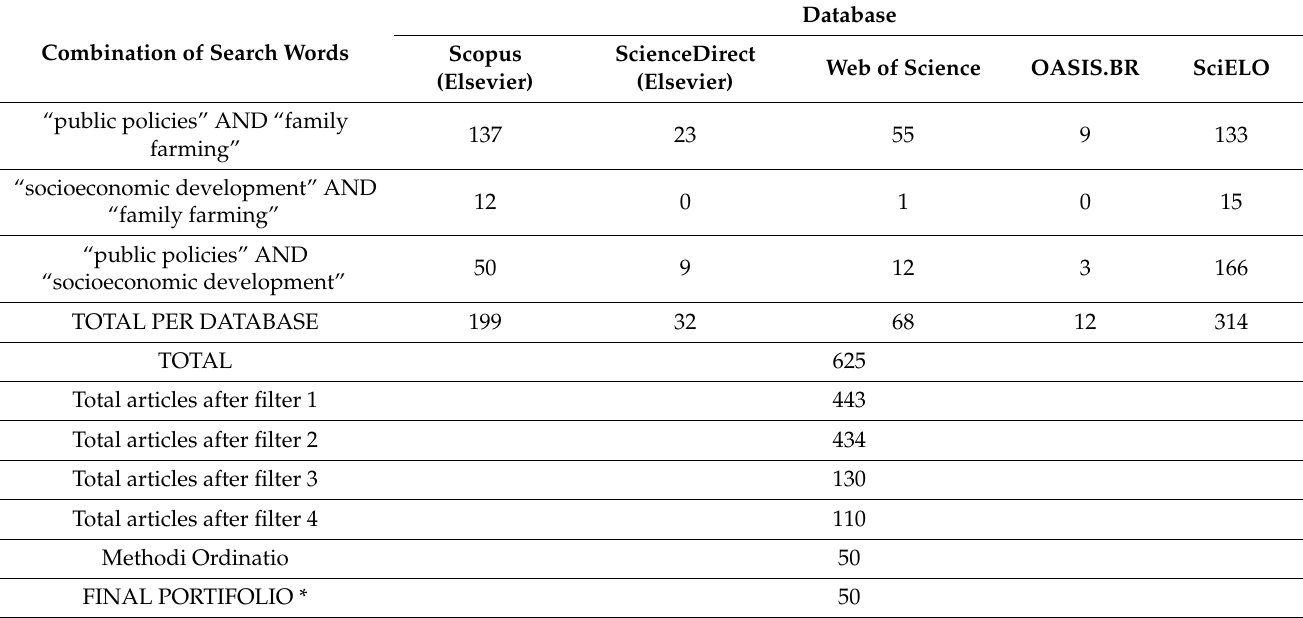
Table 1. Steps followed to achieve the final